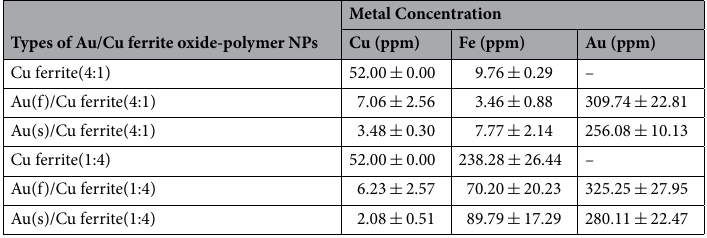
Table 1. Metal concentration of Au/Cu ferrite oxide-polymer core–shell NPs. (n = 6).